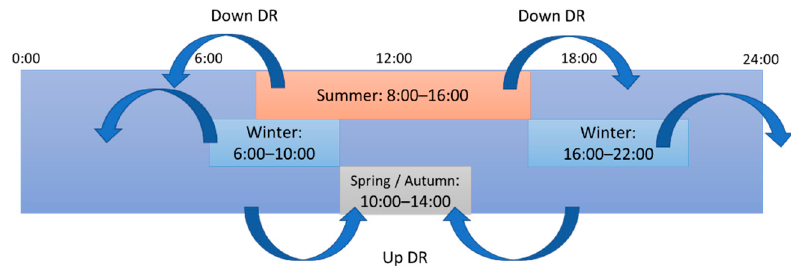
Figure 2. Assumption of DR activation time slot. Summer and winter: stop performing activities during the above time slots and move them to other time slots. Spring / autumn: have activities during other time slots moved to the above time